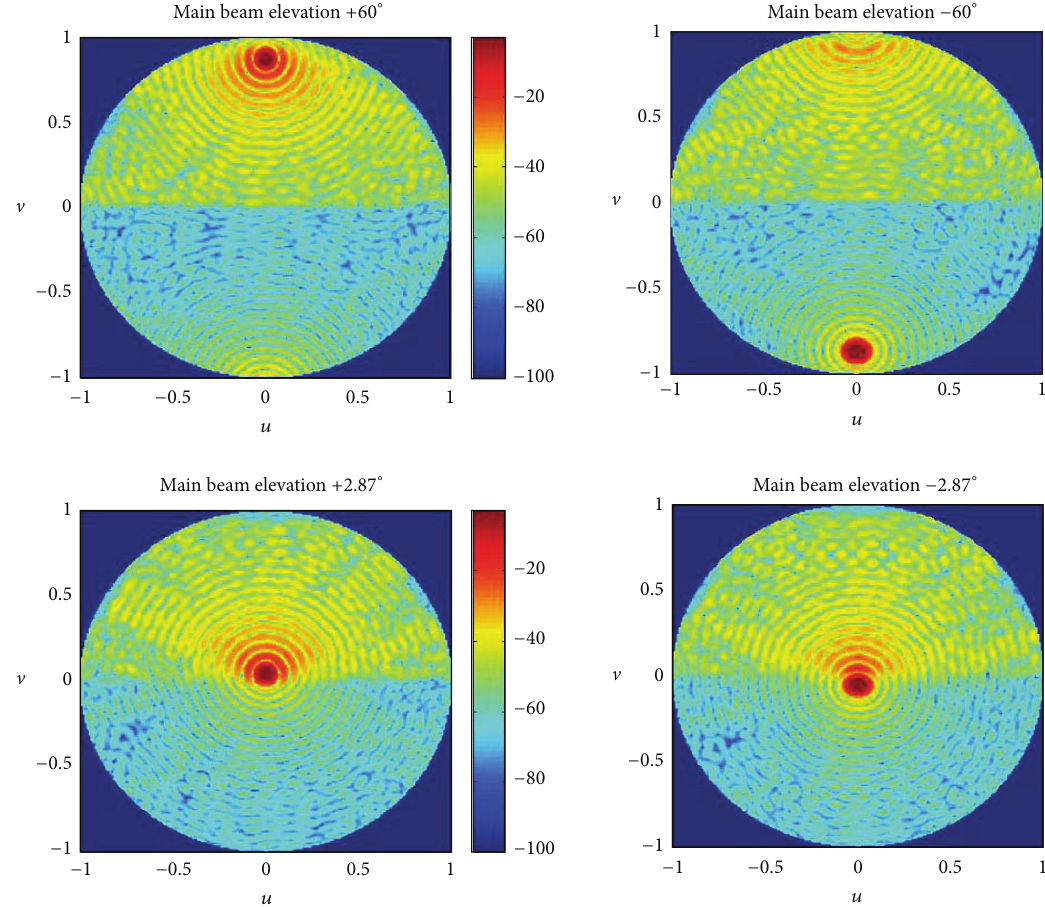
Figure 4: Antenna patterns of planar array with reduced sidelobes at lower elevations for different beam pointing directions (by courtesy of W. B¨urger of Fraunhofer